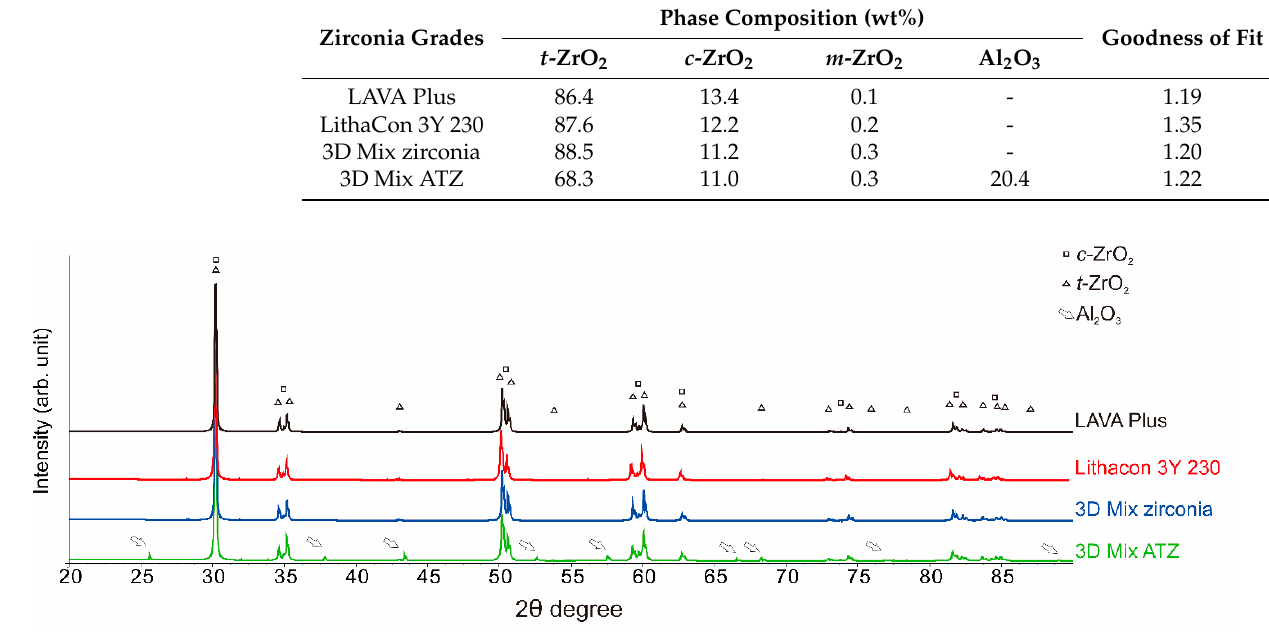
Figure 2. Representative X-ray diffraction (XRD) patterns for the 3Y-TZPs and ATZ investigated. The subtractively manufactured zirconia (LAVA Plus, 3M Oral Care) and additively manufactured zirconia (LithaCon 3Y 230, Lythoz; 3D Mix zirconia, 3DCeram Sinto) present comparable XRD patterns. On the other hand, 3D Mix ATZ (3DCeram Sinto) clearly shows Al 2 O 3 peaks (open white arrows).